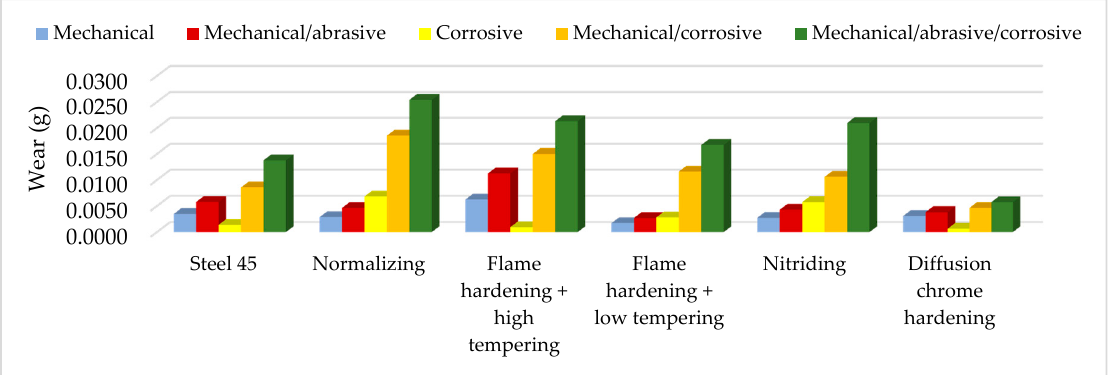
Figure 18. Collective presentation of wear results for all extortions [40].